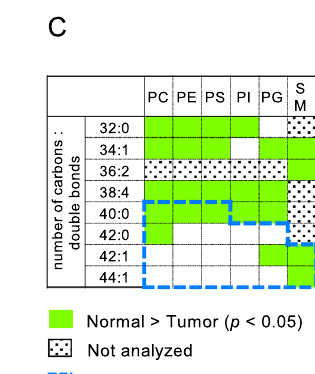
specificities of ELOVL, our results suggested that ELOVL1 was involved in the accumulation of VLCFA in CRC tissues.